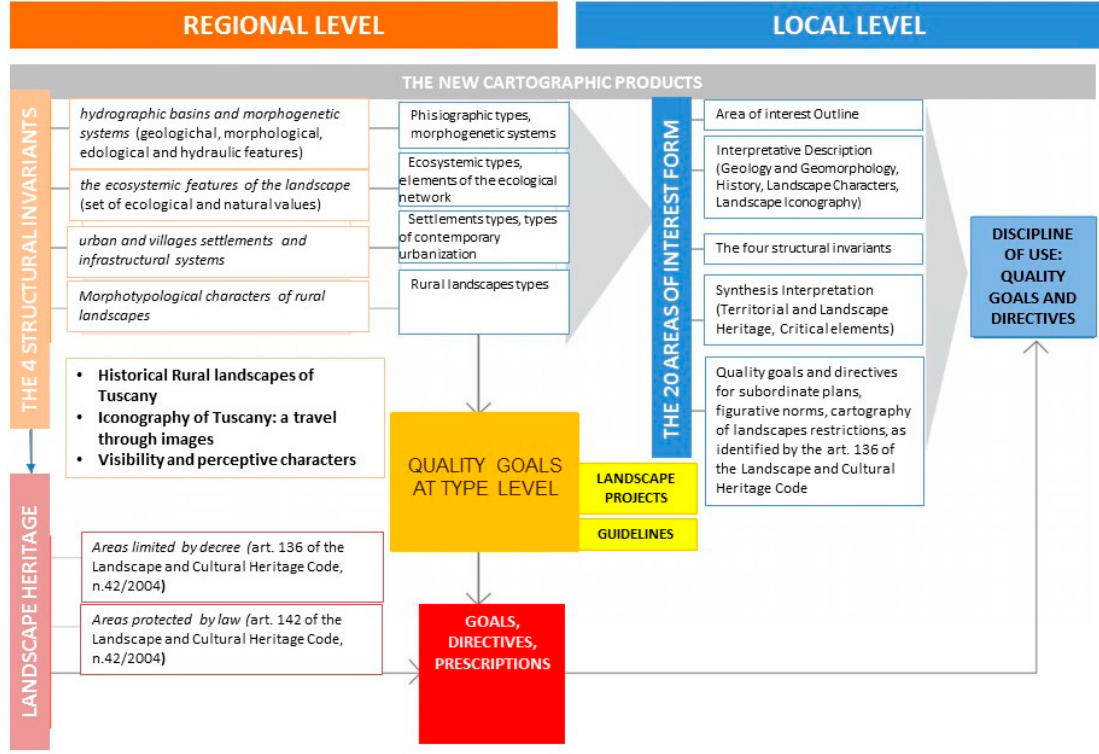
Figure 3. The structure and components of the landscape plan of Tuscany.